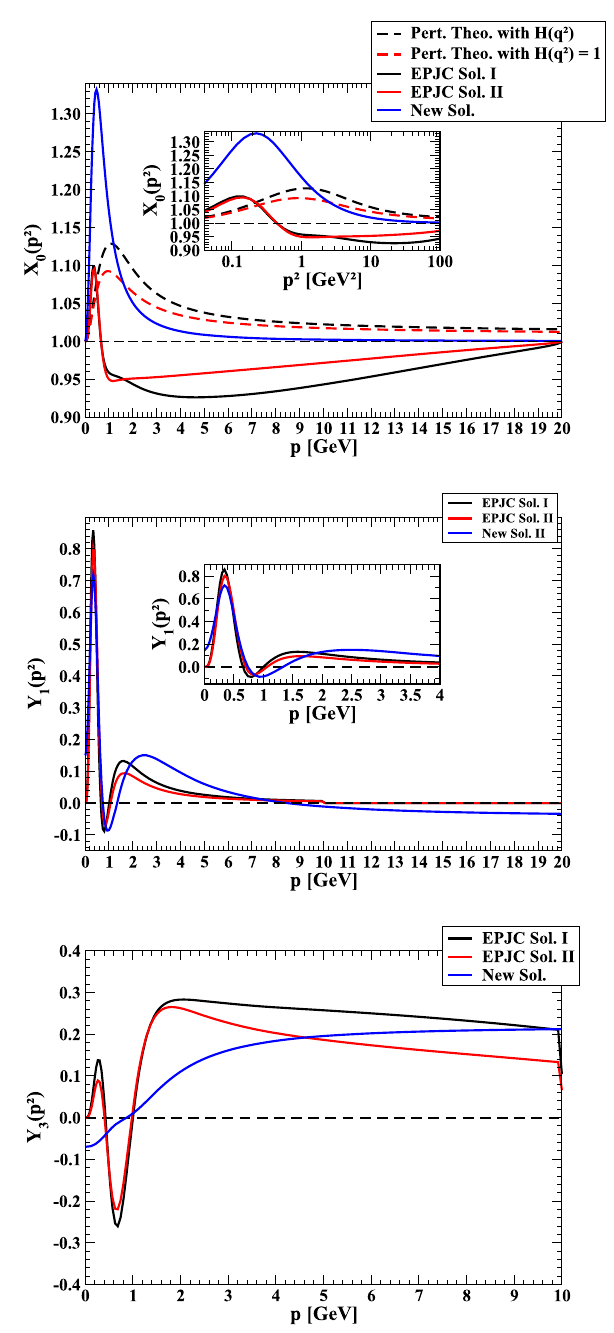
Fig. 4 The solutions I and II found for X 0 ( q 2 ) , Y 1 ( q 2 ) and Y 3 ( q 2 ) in [4] and the new solution found with the Padé parameterisation. See text for details. Also shown are the 1-loop dressed perturbation theory for X 0 ( q 2 ) (dashed lines) using both the tree level gluon-ghost vertex ( H ( q 2 ) = 1) and an improved vertex ghost-gluon vertex [23]